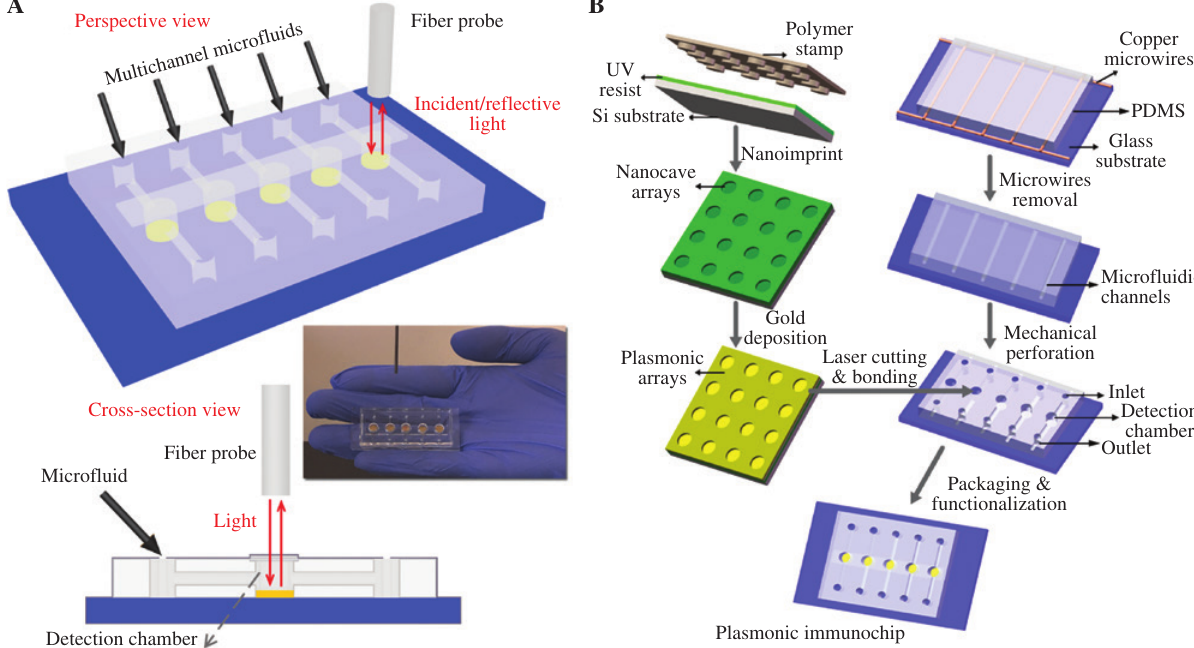
Figure 1: Sensing configuration and biochip fabrication. (A) Schematic drawing of a plasmonic immunochip with a fiber probe. Inset is a photo of the immunochip and fiber probe. (B) Schematic drawing of the fabrication process of the plasmonic